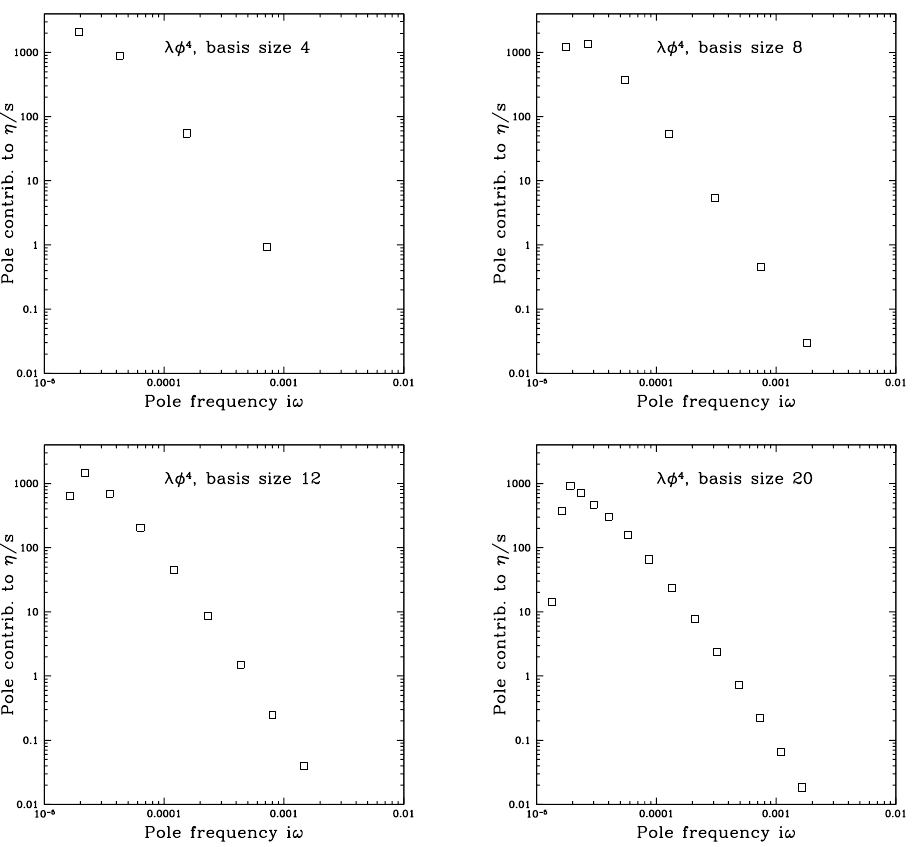
Figure 3 . Location of poles, and contribution of each pole to (cid:17) , for G (cid:25)(cid:25) of the size of the variational Ansatz . From top left to bottom right, the (cid:12)gures represent ( M; N ) of (4 ; 4), (10 ; 8), (16 ; 12), and (20 ; 16). With increasing basis size, the poles span a wider range but also draw closer